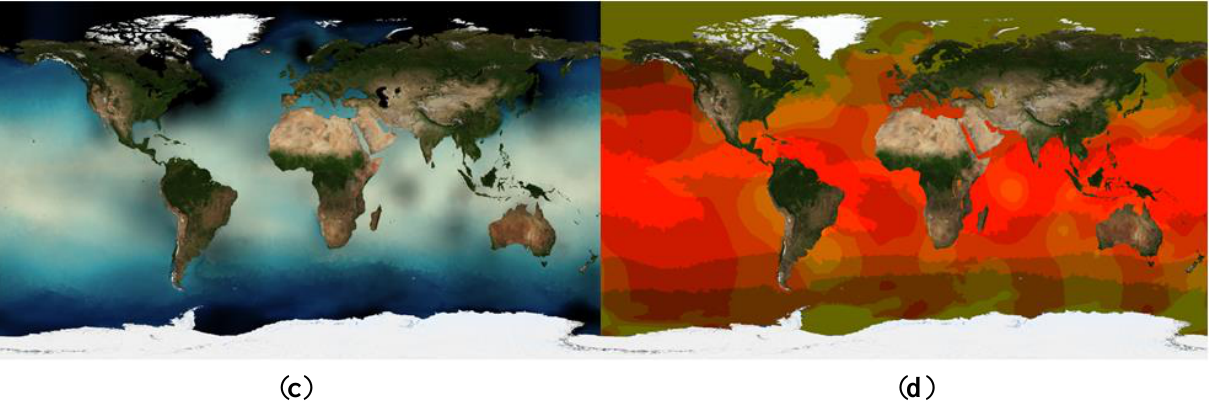
Figure 1. Sample visualisations of sea surface temperature and its uncertainty from the Sea Surface Temperature dataset from the European Space Agency’s Climate Change Initiative (CCI-SST) dataset [19], generated by the ncWMS-Q software (see Section 6.1) using the proposed extensions to the Symbology Encoding (SE) specification (see Section 5.8). From top left: ( a ) temperature encoded as lightness of colour, with overlain contours of its uncertainty (variance); ( b ) uncertainty represented through successive levels of stippling, with denser stippling representing high uncertainty; ( c ) uncertainty represented as black shading; ( d ) use of a bivariate colour map, with temperature encoded as brightness and uncertainty encoded as colour